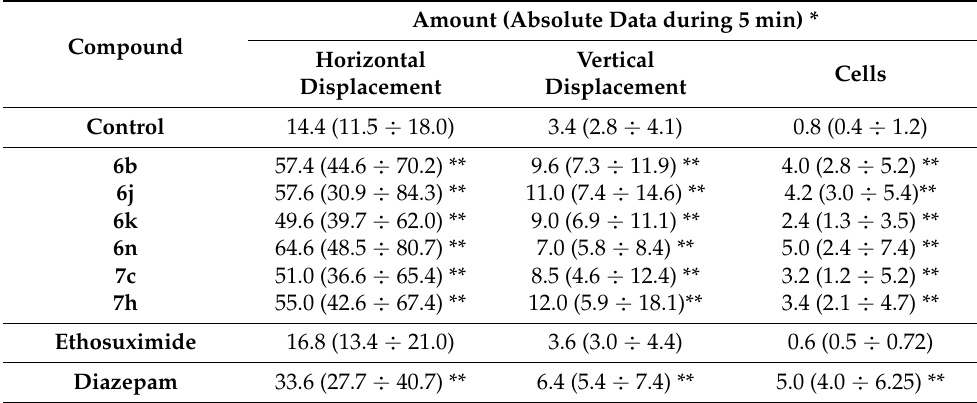
Table 4. Research activity of compounds 6b , j , k , n and 7c , h at a dose of 50 mg/kg, ethosuximide at 200 mg/kg and diazepam at a dose of 2 mg/kg in the “open field” model. Amount (Absolute Data during 5 min) * Compound